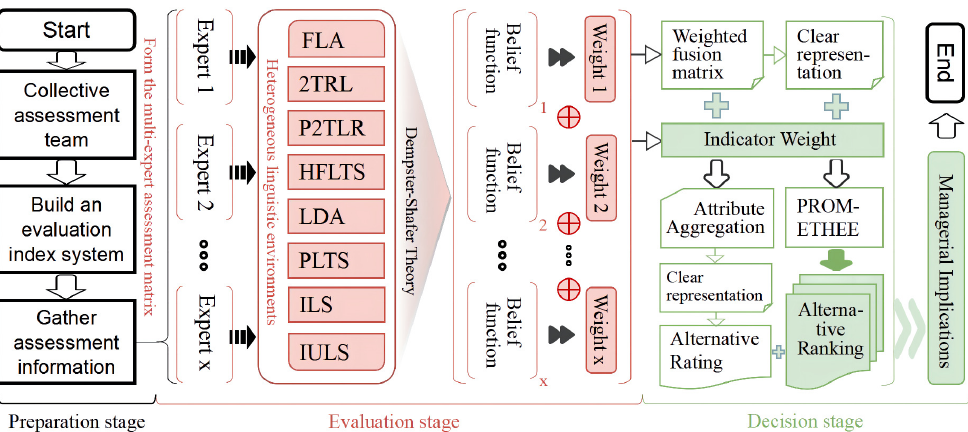
Figure 1. The process for identifying qualified public safety education by using the evidential PROMETHEE